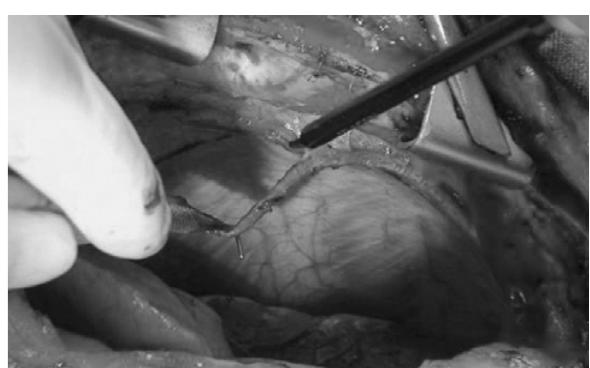
Fig.3 - Coagulação e secção dos vasos intercostais com bisturi ultra-sônico